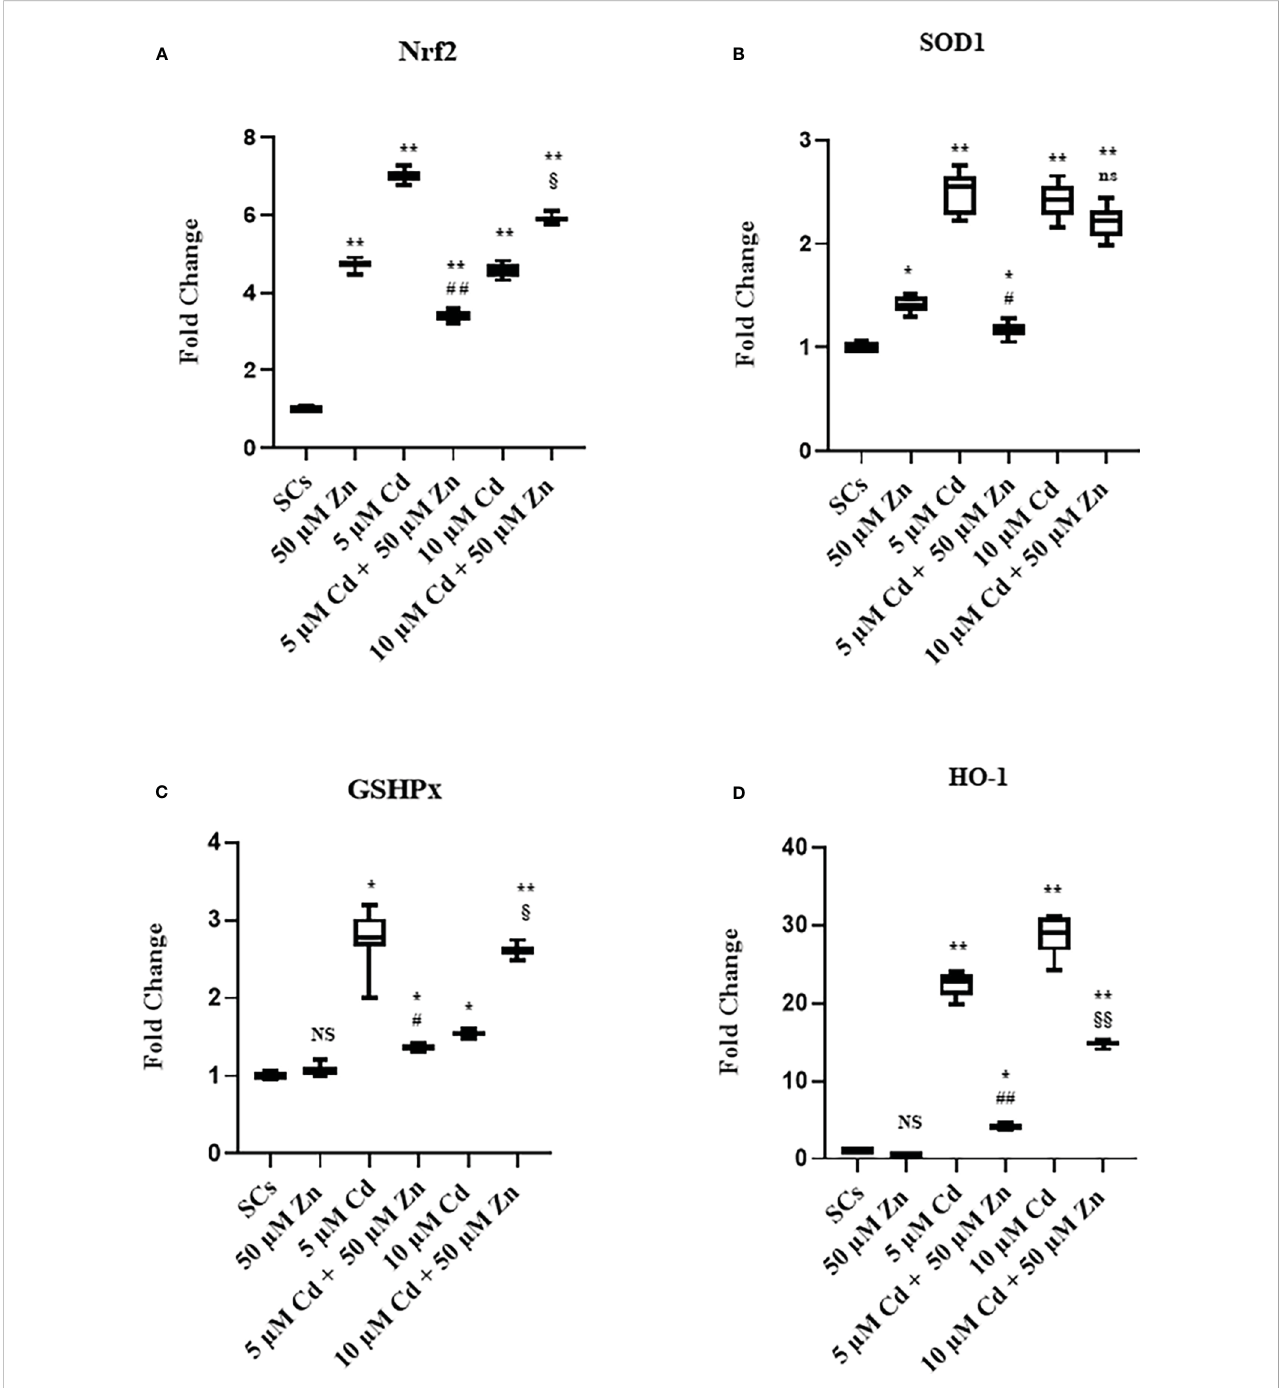
FIGURE 8 Real-time PCR analysis of antioxidant enzymes. Gene expression of Nrf2 (A) , SOD1 (B) , GSHPx (C) , and HO-1 (D) in the absence (unexposed-control group, SCs) or presence of 5 or 10 µM CdCl 2 and/or 50 µM ZnCl2 for 48 h. Data presented as the mean ± SEM (NS vs . SCs, *p < 0.05 and **p < 0.001, #p < 0.05 and ## p < 0.001 vs. 5 µM Cd, §p < 0.05 and §§p < 0.001, (not signi fi cant, ns), ns vs. 10 µM of three independent experiments, each performed in